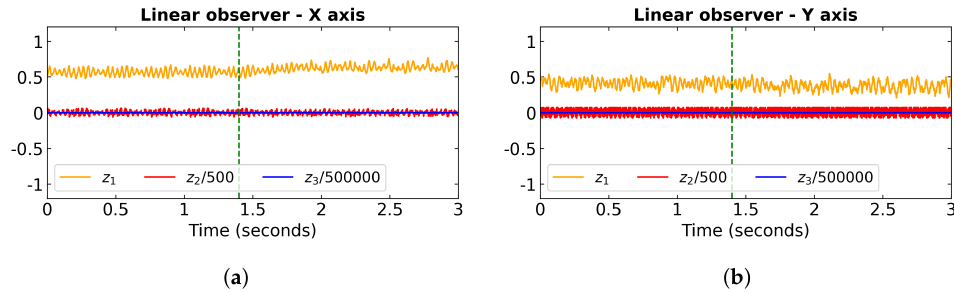
Figure 18. Estimated states behavior for linear ADRC under radial load application. ( a ) Linear ADRC— X -axis states. ( b ) Linear ADRC— Y -axis states.